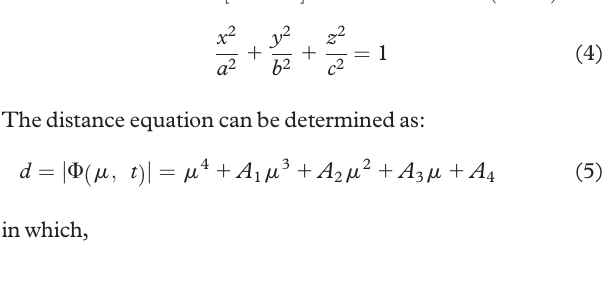
Figure 3 Machine learning process involved in the